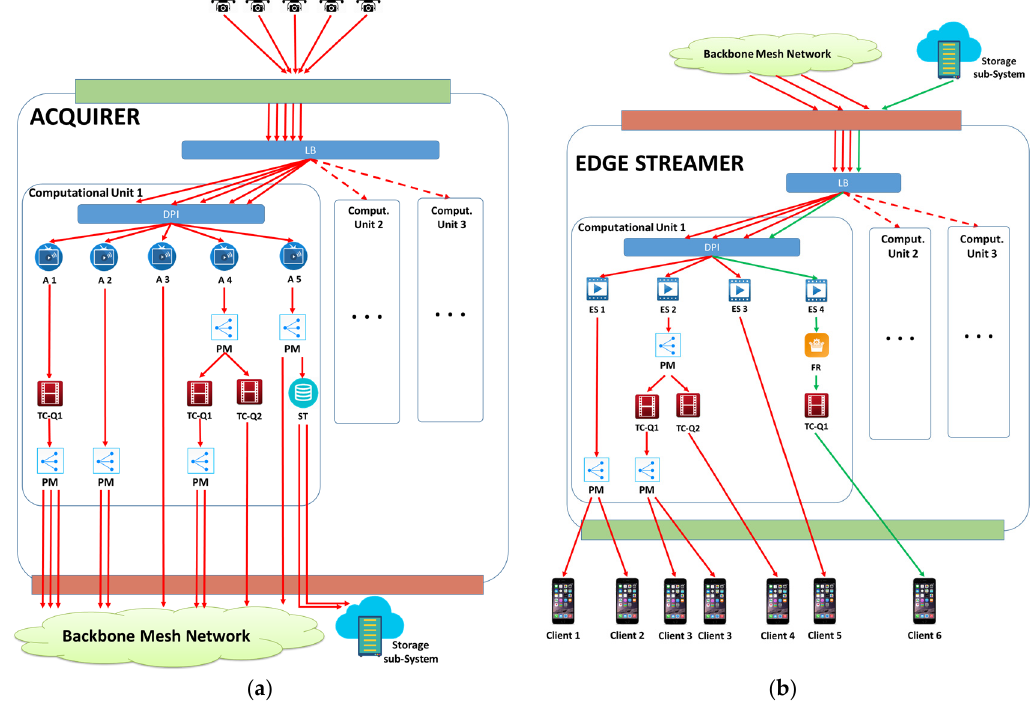
Figure 5. Platform service chains. ( a ) acquirer service chain; ( b ) edge streamer service chain.